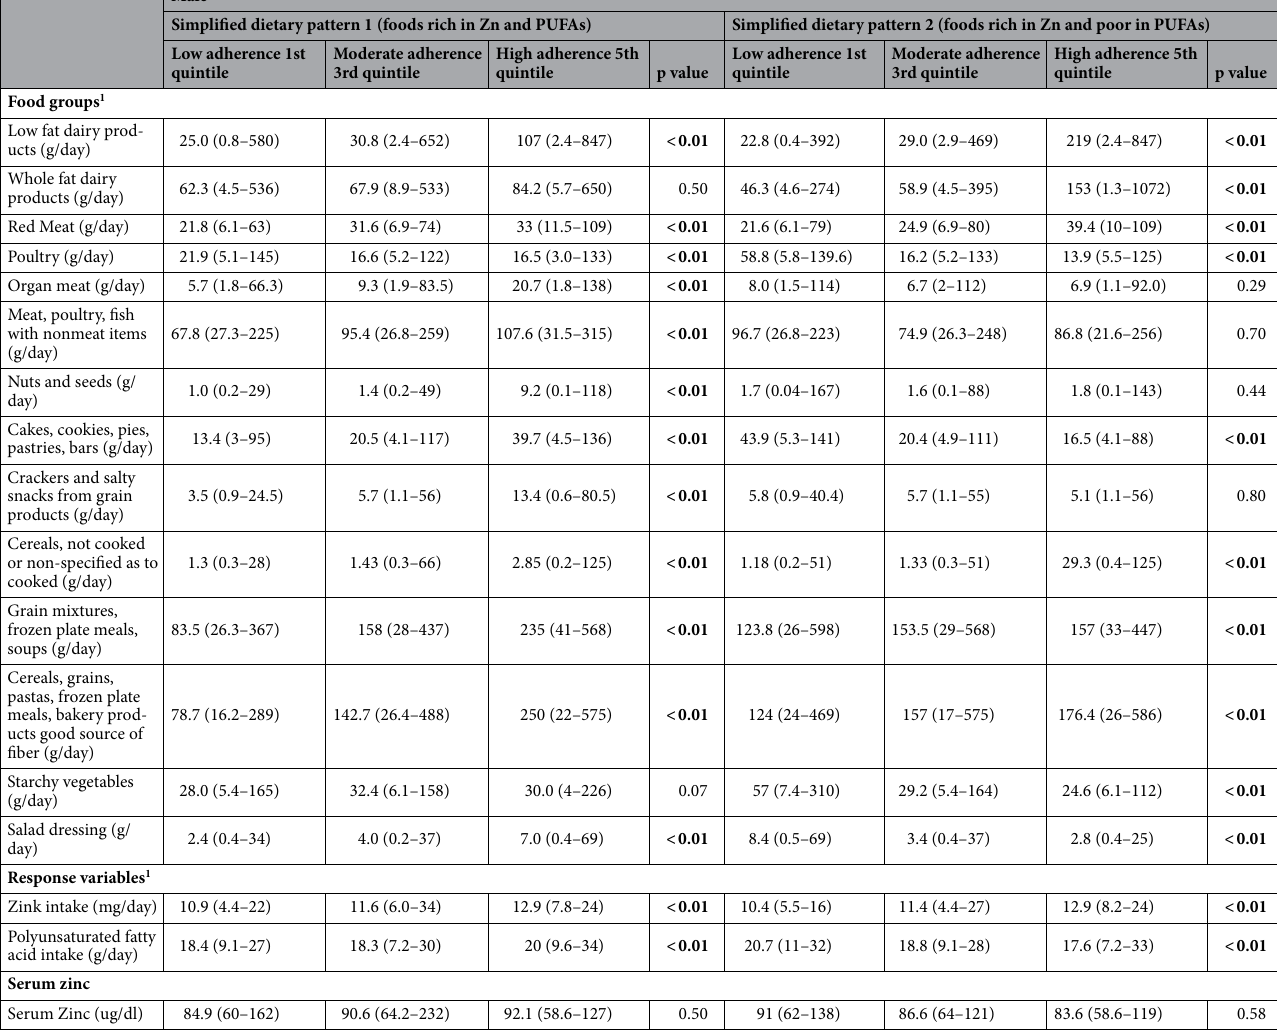
Table 4. Food groups, response variables intakes and serum Zn across quintiles of the simplified dietary pattern score. Male population NHANES 2011–2012. 1 Differences throughout quintiles for food and nutrients intakes were tested using linear trend, adjusting for energy. The top number in each cell is the median value and the data in parenthesis is the